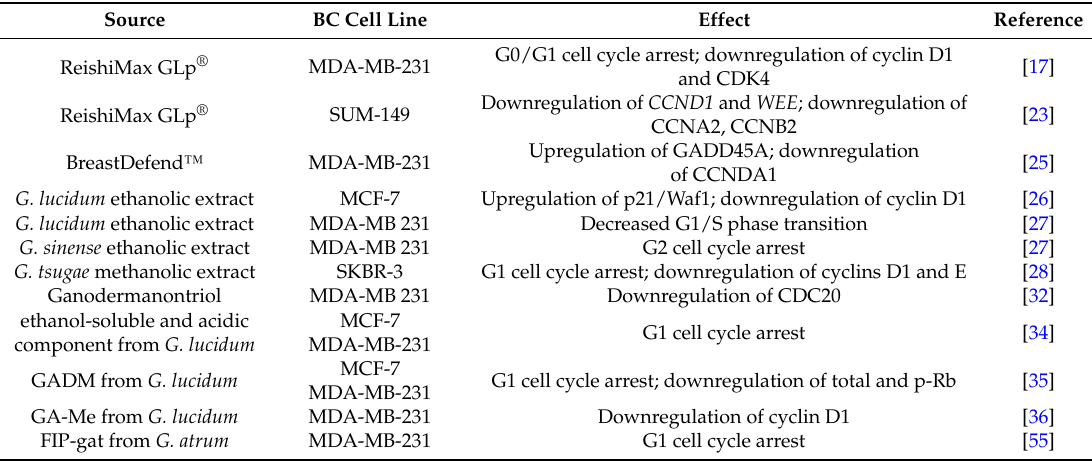
Table 1. Cytostatic effects of Ganoderma